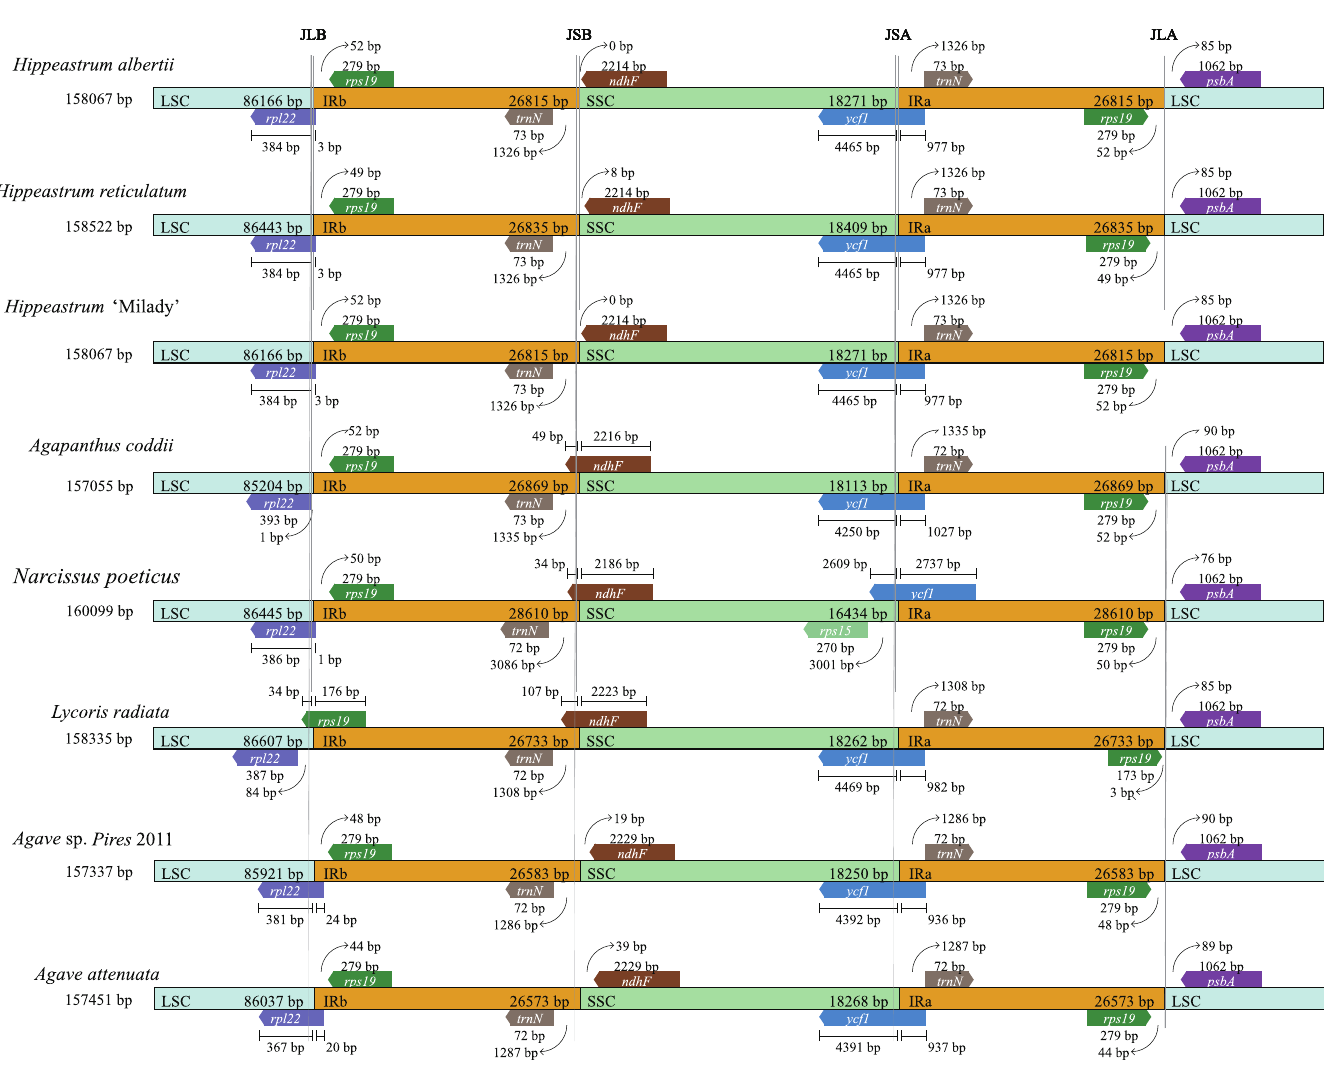
Fig 3. Comparison of the LSC, SSC, and IR regions among eight chloroplast genomes. Boxes above the main line indicate the adjacent border genes. The figure is not to scale with respect to sequence length, and shows only relative changes at or near the IR/SC borders.